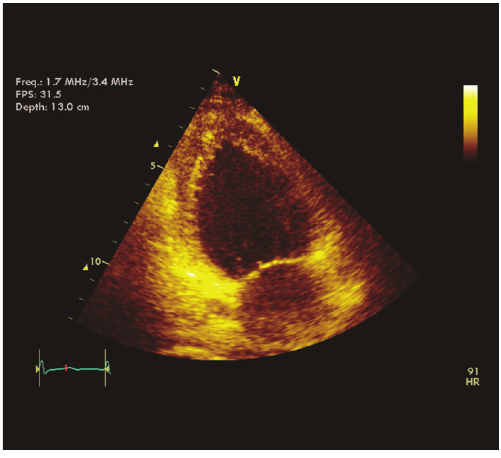
Figure 3: Apical 2-chamber view during systole showing basal hypokinesis and normal apex, the “ace of spades” appearance of left ventricular contractile function.